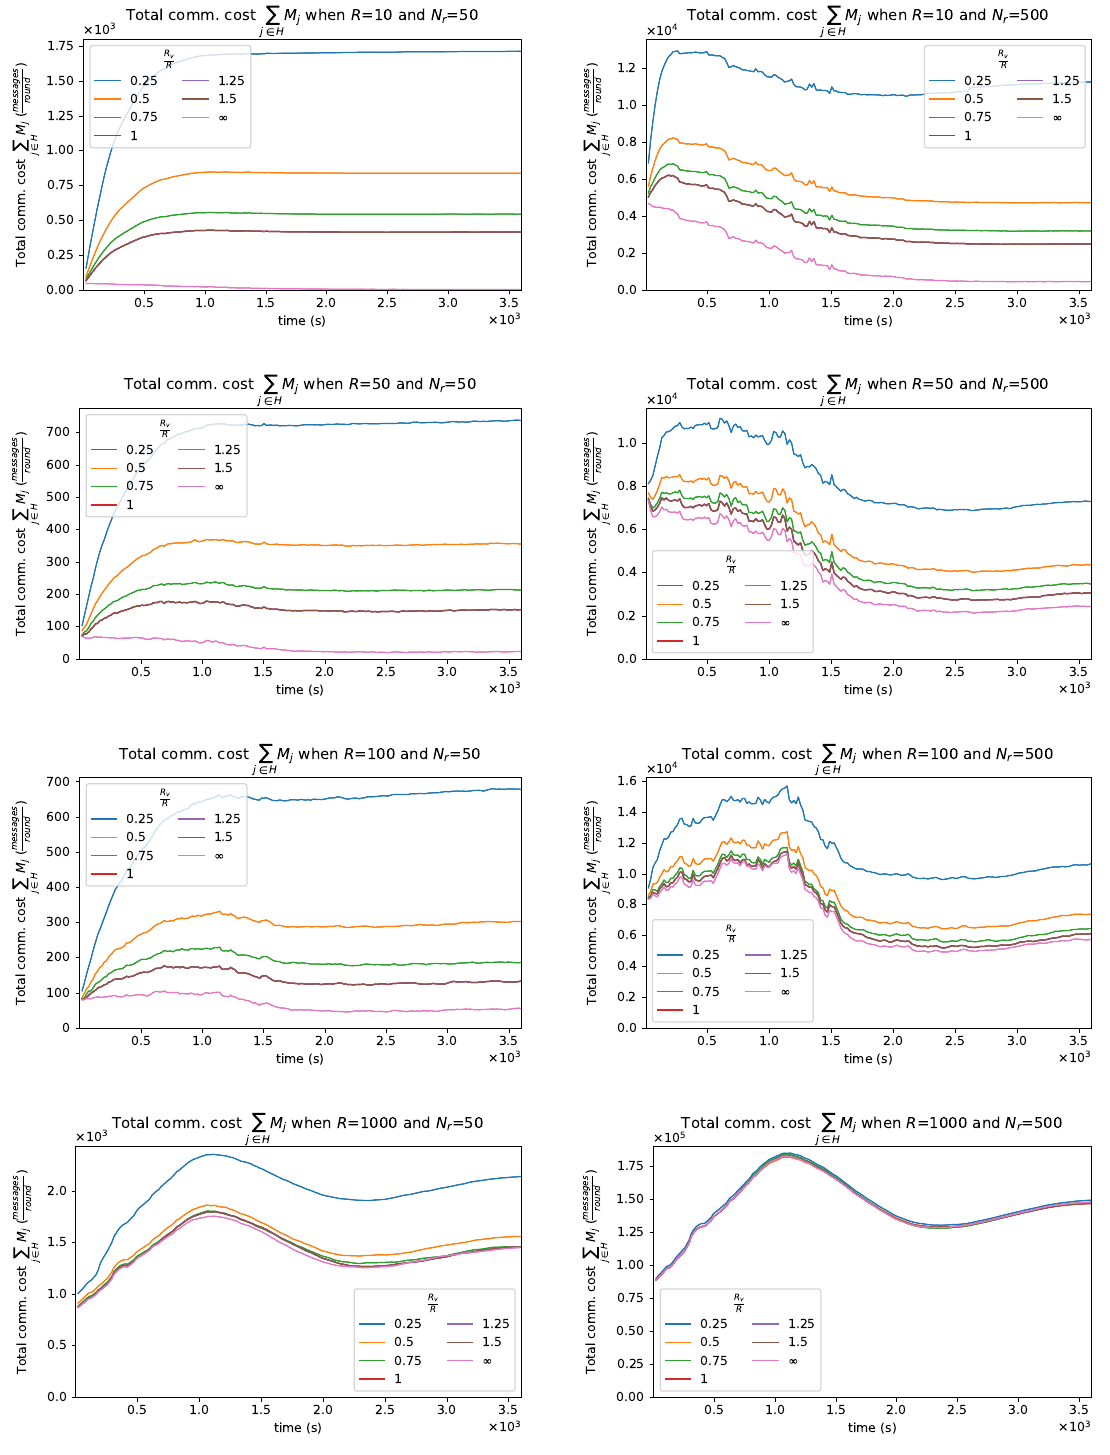
Figure 9. System communication cost, measured as the sum of messages received per round on all real devices ∑ j H M j , for 50 explorers ( left column ) and 500 explorers ( right column ), and increasing ∈ logical communication range R ( top to bottom ). Similarly to the results depicted in Figure 8, the cost grows more than linearly with R v R The cost is lower for intermediate values of R , suggesting that a trade-off in the logical communication range could be found between performance and use of network